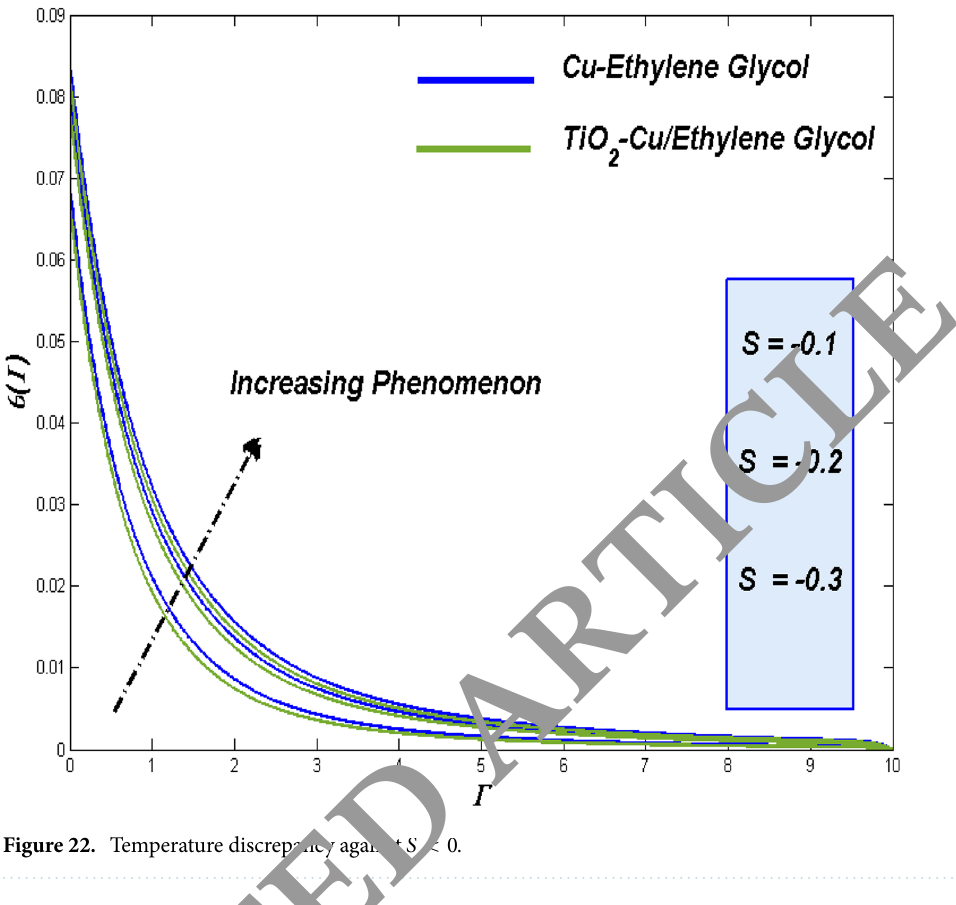
Figure 22. Temperature discrepancy against S < 0